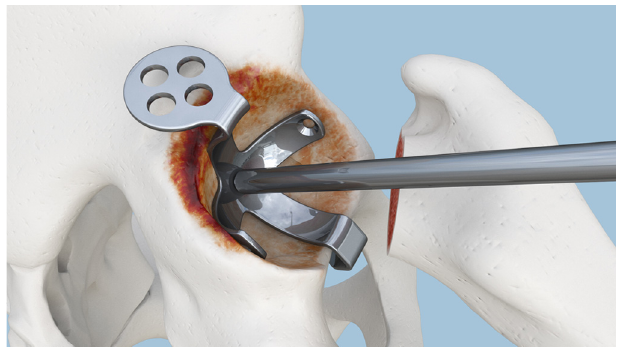
Figure 2. Alignment between cavity center and plate center using Caton